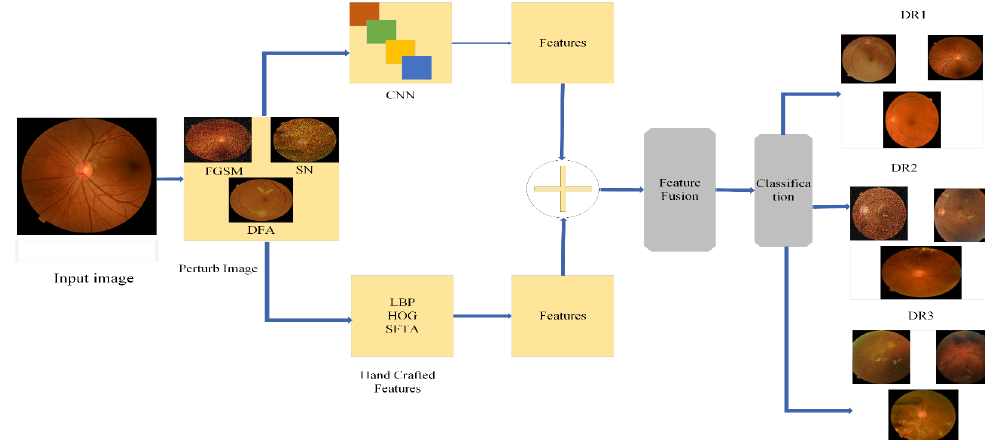
Figure 1. Block diagram of the proposed